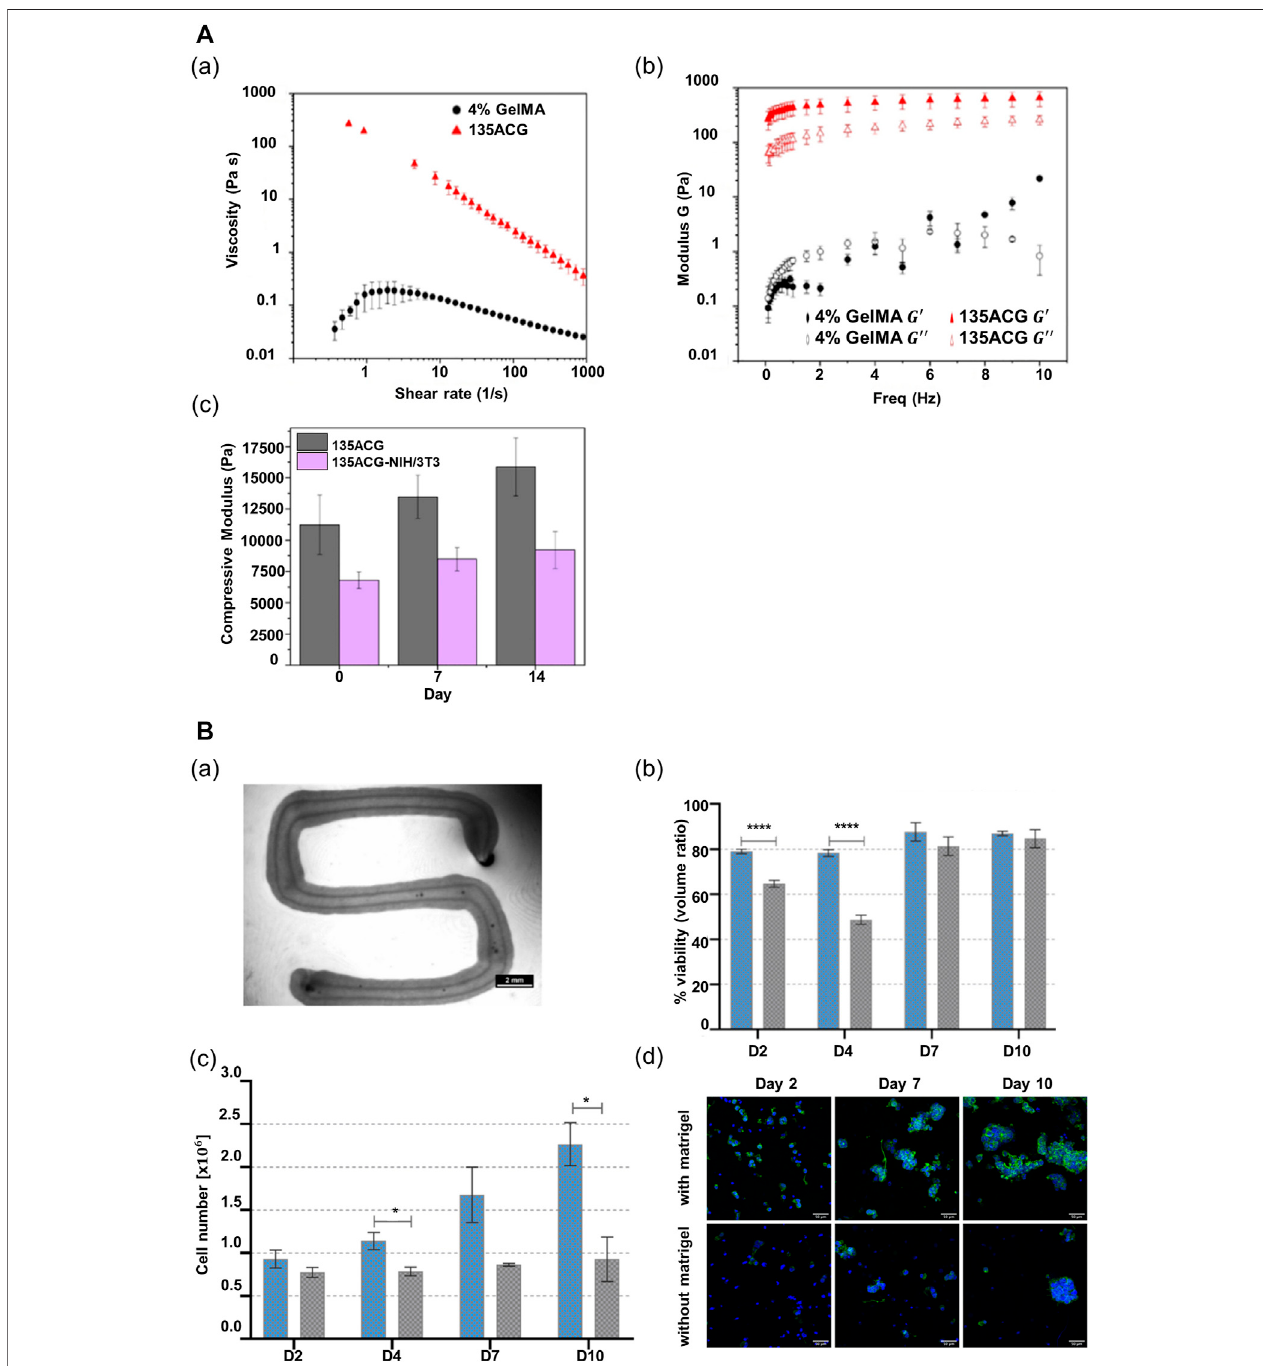
FIGURE 3| Alginate-based multicomponent bioinks. (A) Rheological property of two different bioinks, 4% GelMA and 135ACG. (a) Flow behaviorsof twodifferent bioinks. (b) Elastic modulus ( G ’ ) and viscous modulus ( G } ) of the two different bioinks as a function of oscillatory frequency. (c) Compressive modulus changes of 135ACG gels with/without cells over 14 days. Reproduced withpermissionfrom Wu et al. (2020). (B) Characteristics ofalgMC bioink.(a) Stereo microscopic image ofa cell-free core – shell strand with compartmentalized core and shell structure within the strand. Scale bar: 2 mm. (b) Viability of HepG2 cells encapsulated in algMC bioink comparing two conditions (with matrigel vs without matrigel) ( n = 6, mean ± SD, **** p < 0.0001). (c) Proliferation of HepG2 cells encapsulated in algMC bioink comparingtwoconditions(withmatrigelvswithoutmatrigel)( n =3,mean±SD,* p < 0.05).(d)MorphologyandorganizationofHepG2encapsulatedinalgMCcomparing two conditions (with matrigel vs without matrigel). Reproduced with permission from Taymour et al. (2021).